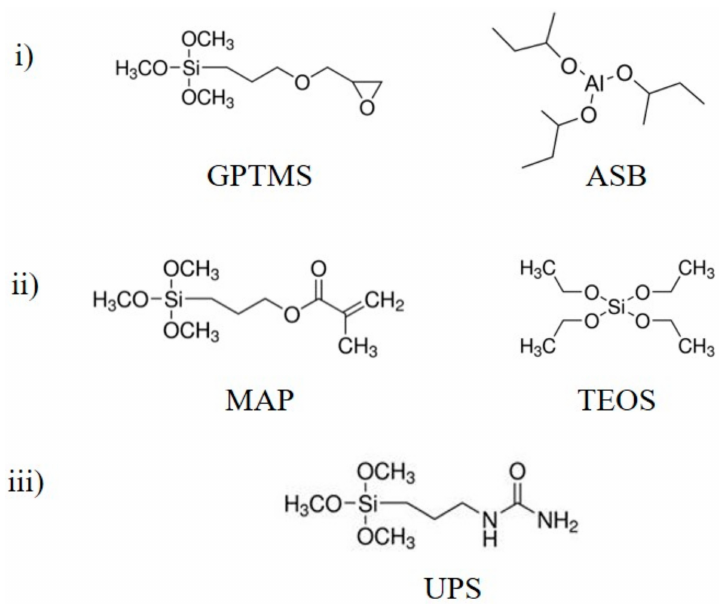
Figure 1. Chemical structures of organic and inorganic network precursors: ( i ) GPTMS and ASB, ( ii ) MAP and TEOS, and ( iii ) UPS.